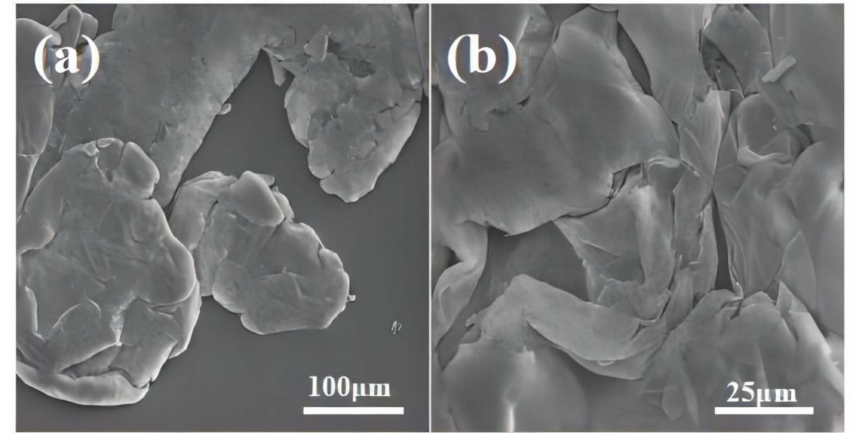
Figure 1. SEM image of expanded graphite: ( a ) Overall morphology of expanded graphite; ( b ) Partial magnification of expanded